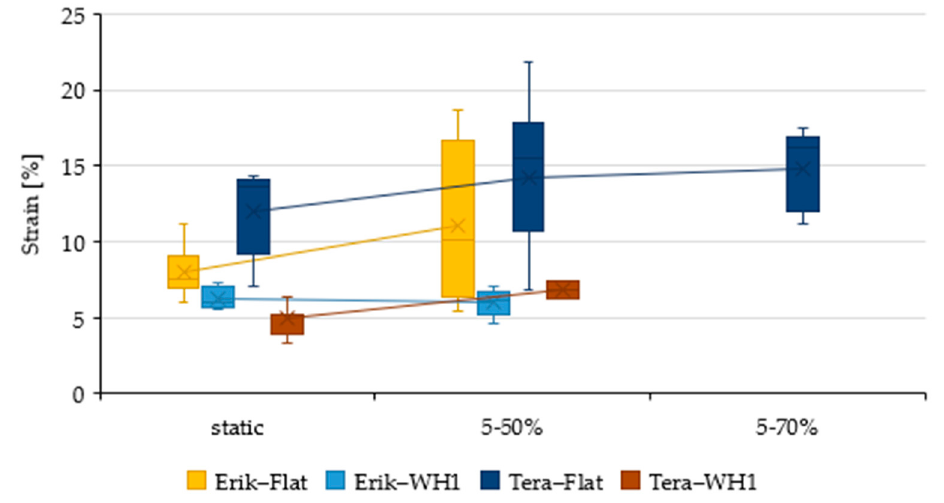
Figure 7. Evaluation of the strain of the adhesive bonds under static loading and cyclic loading in the load intervals 5–50% and 5–70%.